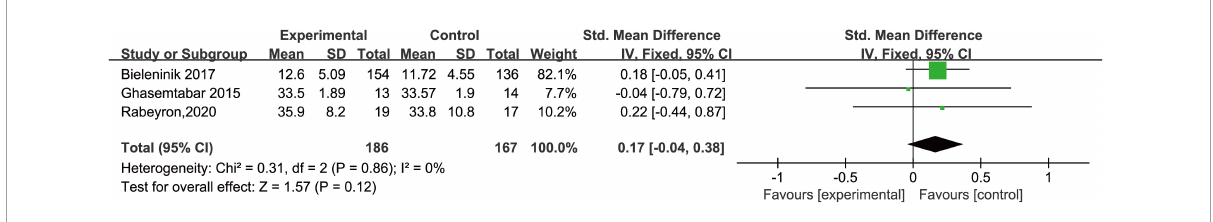
FIGURE3 Forest plots of the effect of MT on symptoms severity compared with no MT; SD, standard deviation; 95% CI: 95% confidence interval; IV: inverse variance method.